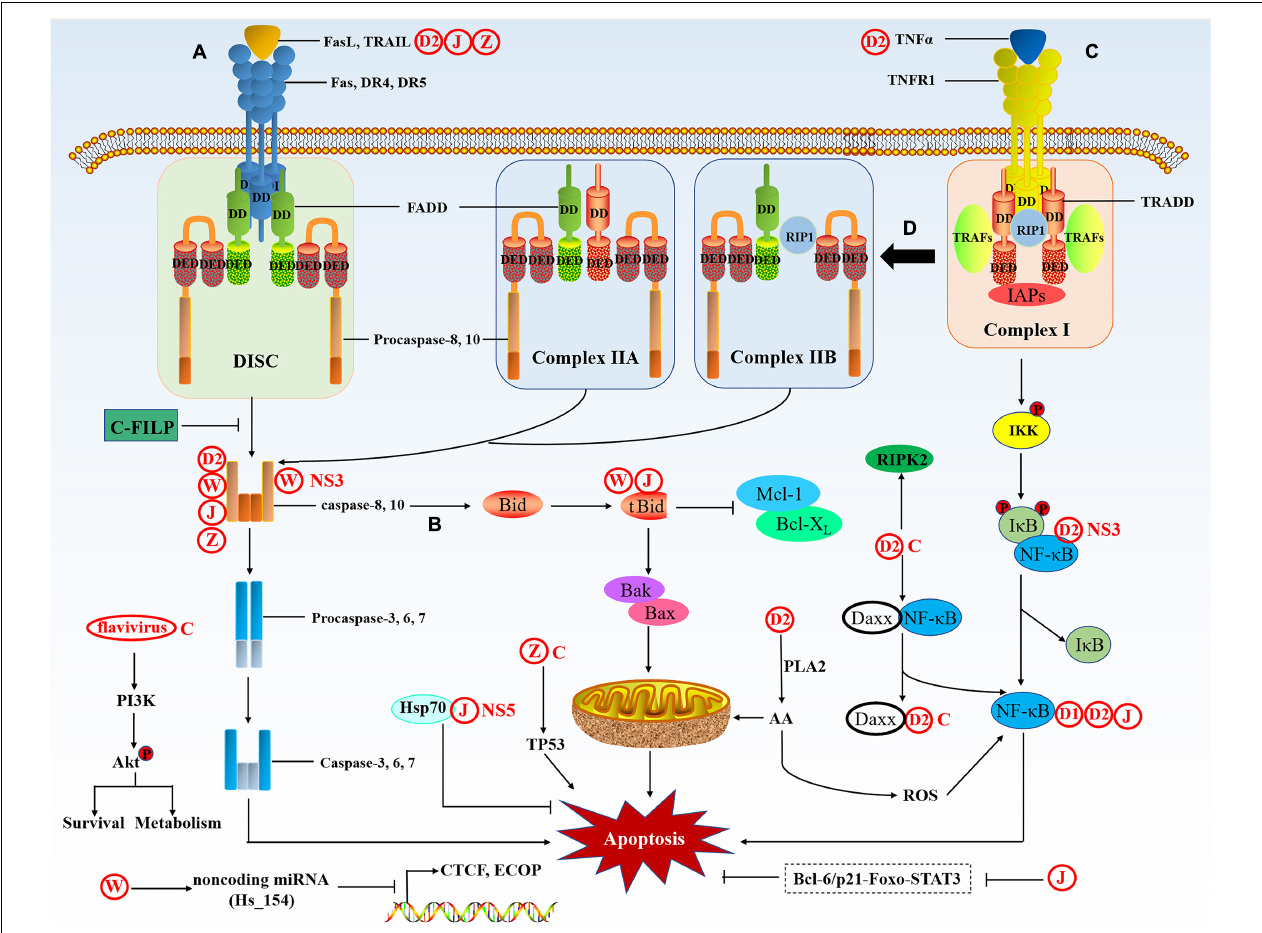
FIGURE 4 | The extrinsic apoptotic pathway. The extrinsic pathway is activated by death signals mediated by death ligands. (A) Fas and DR4/5 are activated by the binding of their respective ligands FasL and TRAIL; the receptors then bind to FADD via the DD. Then, the DED of FADD binds to procaspase-8/10, which forms a complex called the DISC and sends a signal to activate caspase-8 and -10, then caspase-8 and -10 induce the activation of the caspase cascade and ultimately results in apoptosis. (B) In a particular cell, the extrinsic pathway can crosstalk with the intrinsic pathway through caspase-8-mediated truncation of Bid to tBid. tBid activates BAK/BAX oligomerization and induces apoptosis through the mitochondrial pathway. (C) TNFR1 is activated by the binding of its respective ligand TNF α . TNFR1 recruits TRADD, an adaptor protein that binds to TRAFs, RIP1, and IAPs, forming the initial membrane complex (complex I), which stimulates the NF- κ B pathways to facilitate apoptosis. (D) Complex I forms two types of cytoplasmic apoptotic complexes, TRADD-dependent complex IIA and RIP1-dependent complex IIB, which activate caspase-8, thus initiating apoptosis.